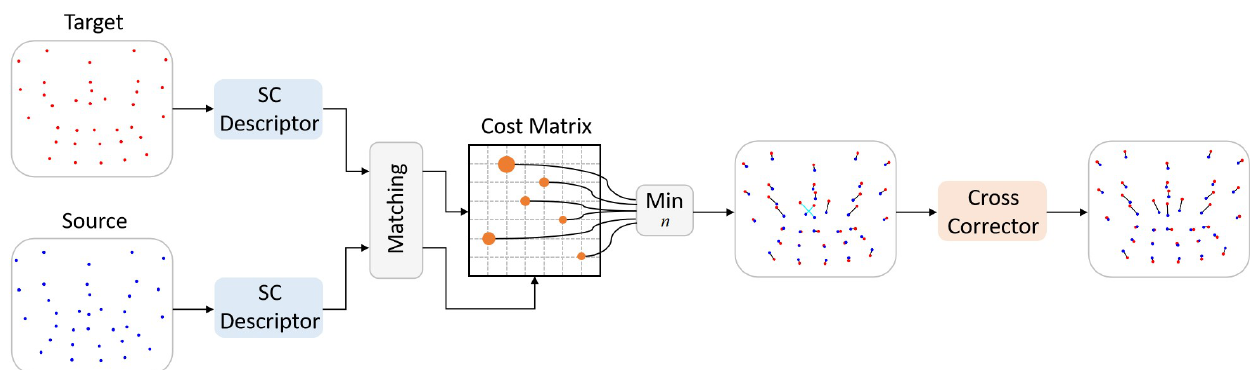
Figure 6. Overview of the fine matching